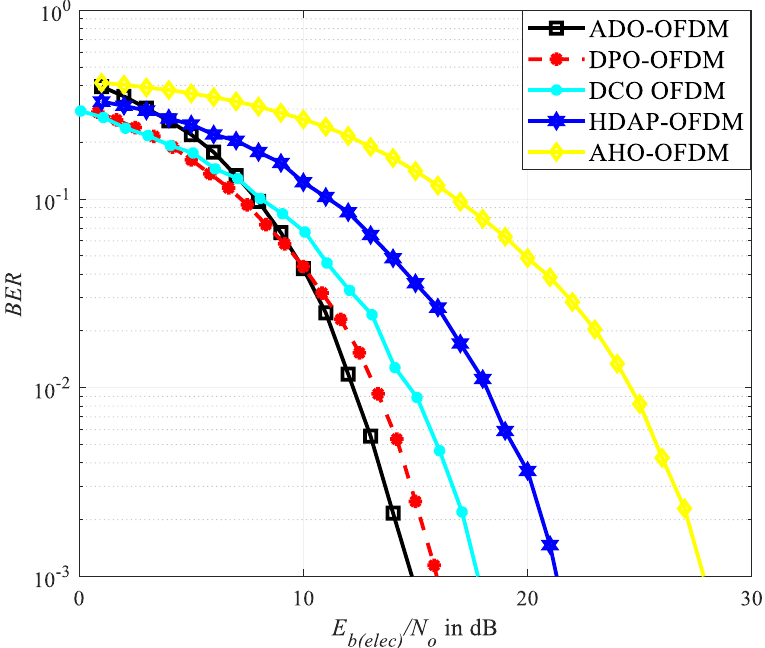
Figure 4. Bit error rate (BER) versus electrical energy per bit to noise power spectral density ( 𝐸 𝑏(𝑒𝑙𝑒𝑐) /𝑁 𝑂 ) for different orthogonal frequency division multiplexing (OFDM) forms.